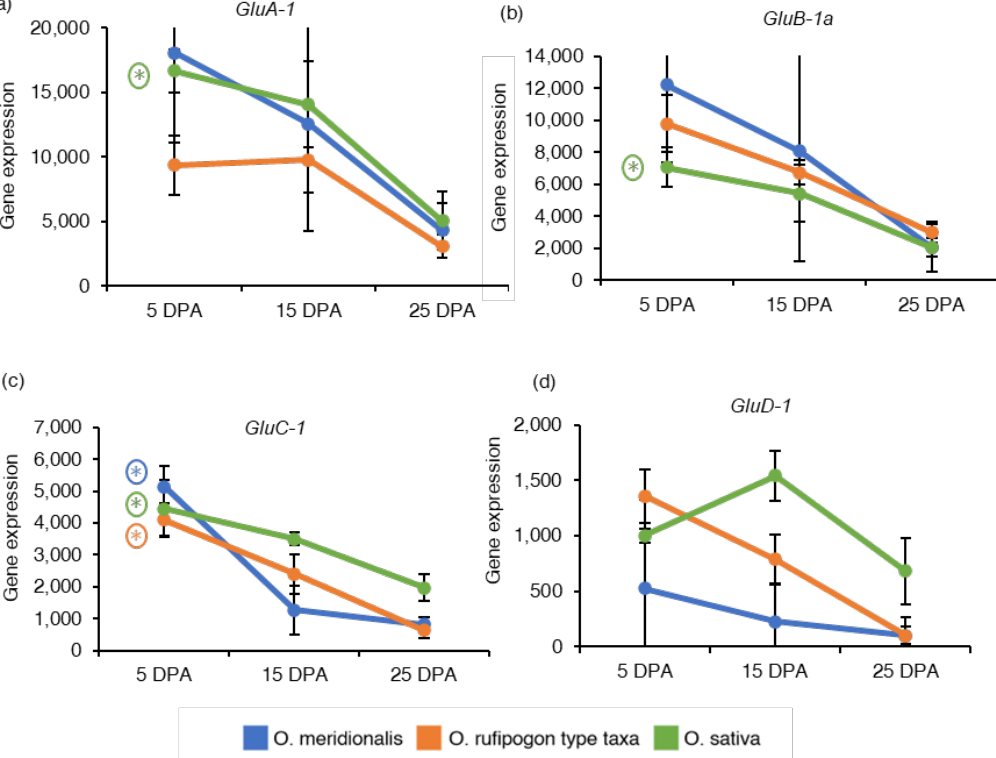
Figure 4. Gene expression of seed storage proteins related genes: ( a ) Glutelin type A-1 ( GluA-1 ), ( b ) Glutelin type B-1a ( GluB-1a ), ( c ) Glutelin type C-1 ( GluC-1 ), and ( d ) Glutelin type D-1 ( GluD-1 ). The y- axis represents gene expression based on RNA-Seq analysis and expressed as reads per kilobase of transcript per million reads mapped (RPKM) values. The x-axis represents the days post anthesis (DPA). Data are presented as mean ± standard deviation of three biological replicates for O. merid- ionalis and O. sativa and four biological replicates for O. rufipogon type taxa (except for 25 DPA with three replicates). * symbol above the line between two DPA represents significant differential gene expression and (*) with a circle represents significant differential gene expression between 5 DPA and 25 DPA.